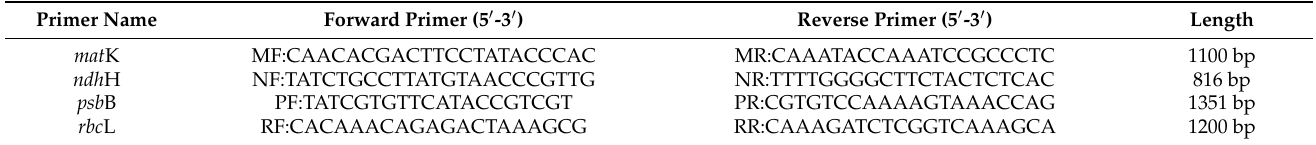
Table 2. Information of four pairs of cpDNA primers in this